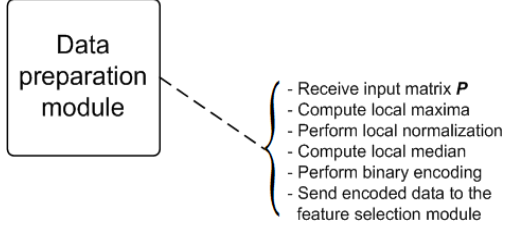
Figure 3. Data preparation